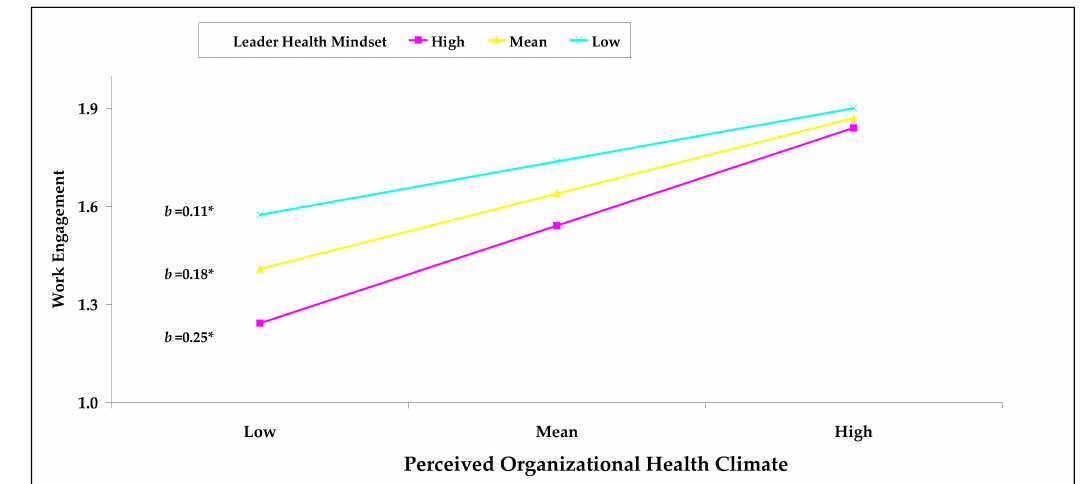
Figure 1. Interaction effect of POHC and LHM on work engagement. Note: N = 301; POHC = perceived organizational health climate; LHM = leader health mindset; b = unstandardized coefficient. * p < 0.05.